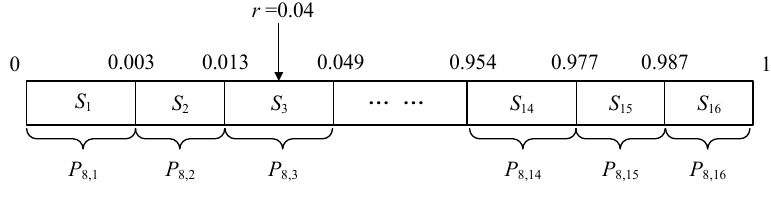
7 of 25 Figure 3. Graphical representation of the Markov transition matrix.